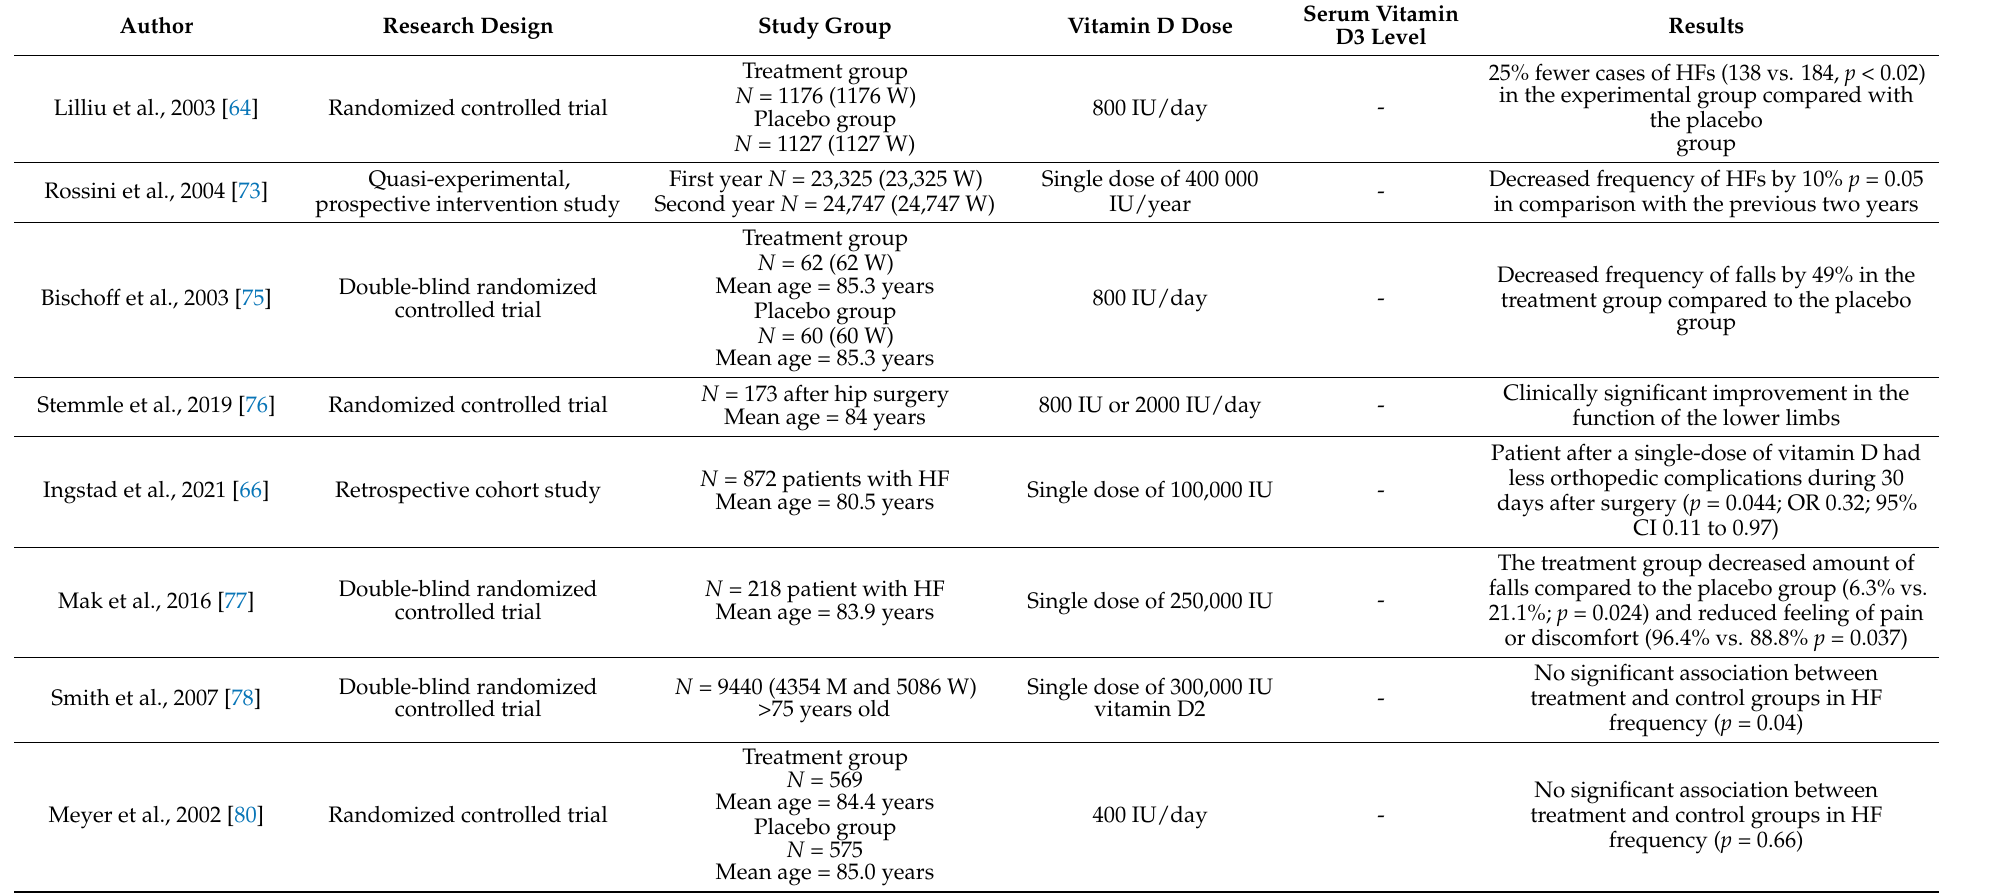
Table 3. Vitamin D supplementation and hip